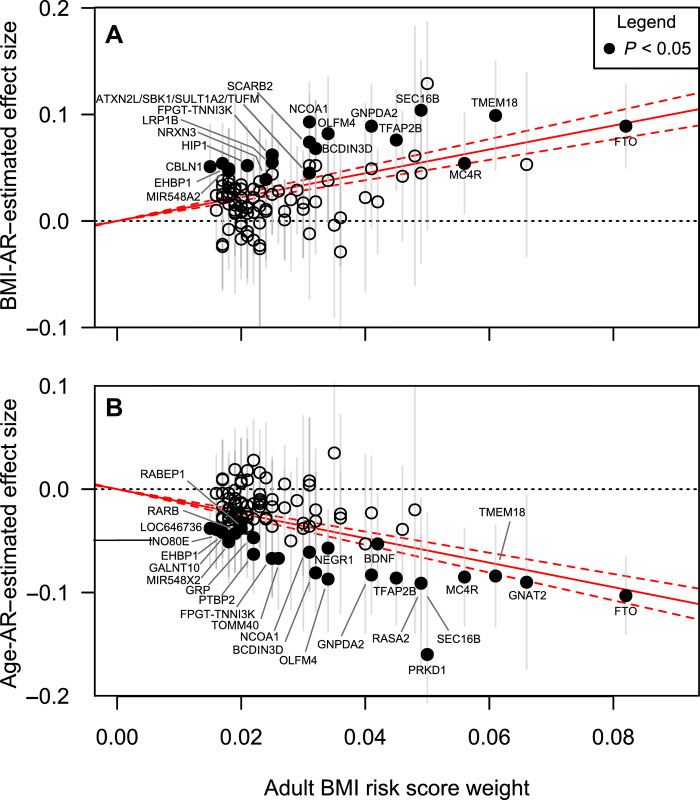
Adult BMI GRS analysis of early growth traits.Scatter plots show the effect size estimates (SD units) of the 97 adult BMI-associated SNP in GIANT consortium in the x axis and the corresponding effect size estimates (SD units) of the looked-up SNP of stage 1 meta-analysis GWAS on (A) BMI-AR and (B) Age-AR in the y axis. The effect size of the adult BMI increasing allele is plotted. The solid red line is the estimated effect of the GRS on the early growth phenotype, taking into account the uncertainty of the point estimates. The dashed line is the 95% CI of the predicted effect. Stage 1 meta-analysis GWAS SNPs with P < 0.05 are plotted with a solid circle and labeled with the nearest gene name. The scatter plots of the other early growth phenotypes are given in fig. S10.